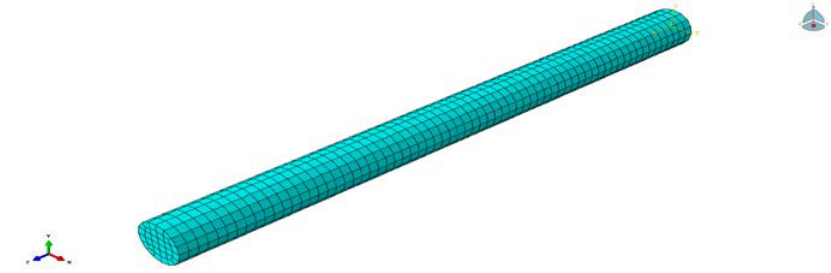
Figure 4. Air-filled pipe model meshed using the acoustic continuum 3D 20-node brick elements (AC3D20).